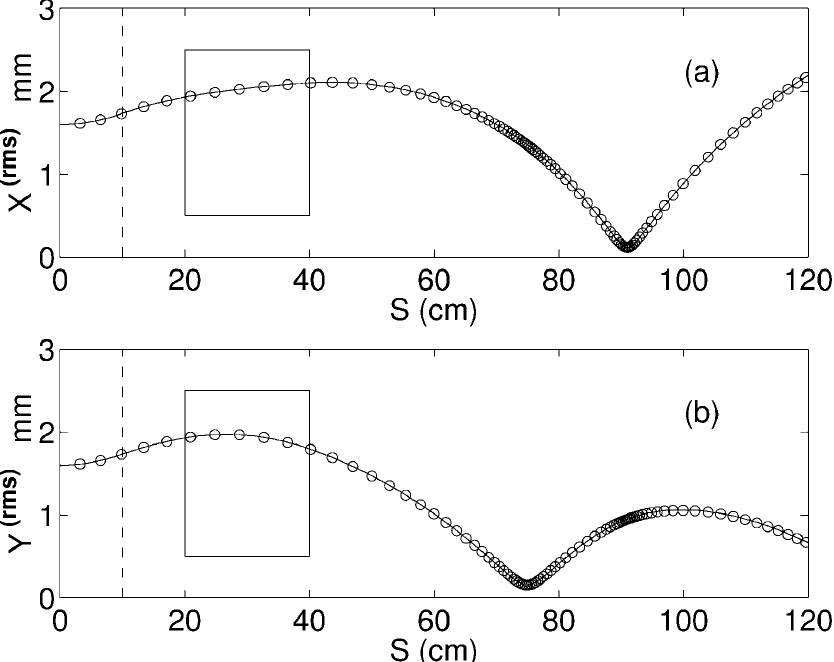
FIG. 2. The rms half-width of the profile predicted by the simulation for a KV electron beam in a hypothetical transport line for (a) the x - s plane and (b) the y - s plane. The KV equations are used to generate the solid line; open circles are from the simulation. The box marks the relative s position of the quadrupole magnet. The transition from f (cid:1) 0 to f (cid:1) 1 is shown by the vertical dashed line. All figures are from simulations using Hockney’s algorithm unless otherwise